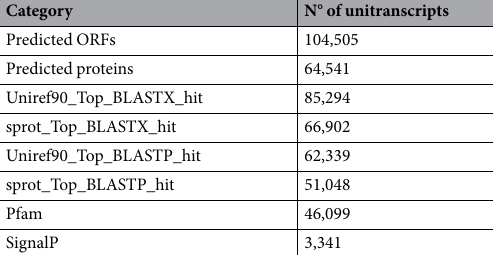
Category N° of unitranscripts